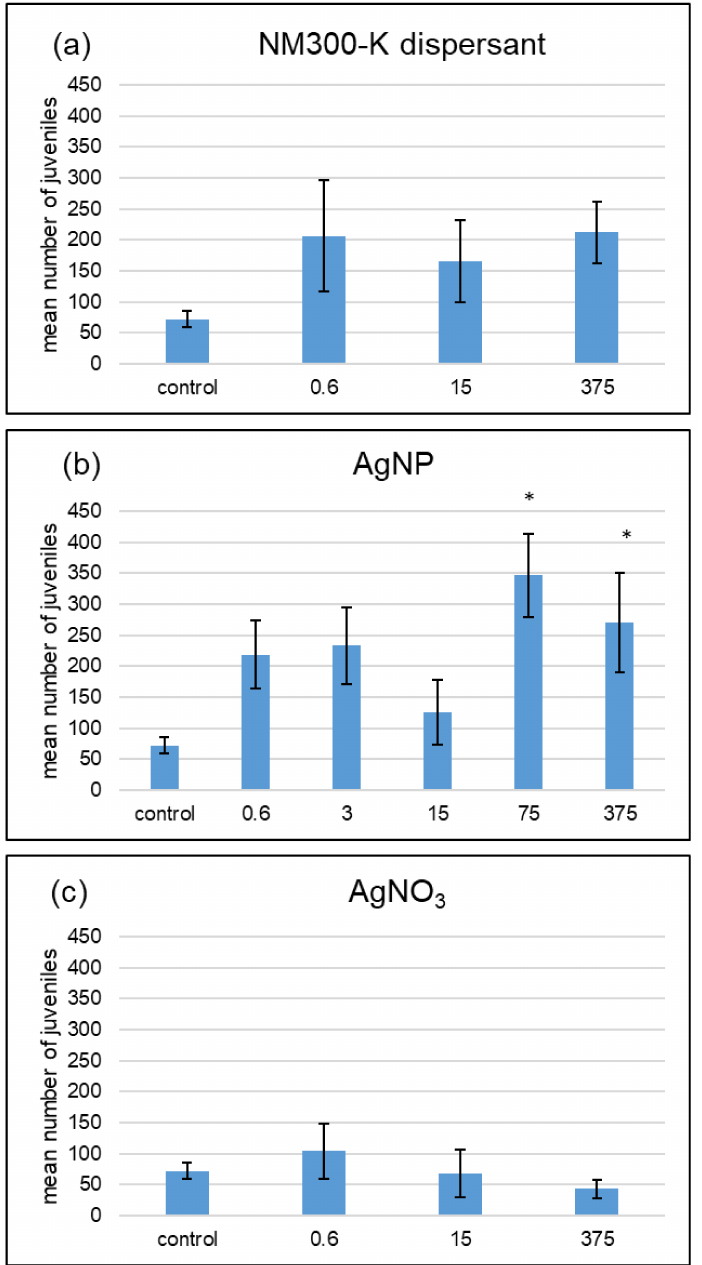
Figure 4. Effects of NM-300K dispersant ( a ), AgNP NM-300K ( b ), and AgNO 3 ( c ) at 60% maximum water holding capacity on F. candida reproduction. Results of a 28-day reproduction test based on the miniaturized OECD test of Filser et al. (2014) [21]. The unit is µ g Ag · kg − 1 soil and the dispersant treatments have the same amount of dispersant as the AgNP treatment labeled with the same concentration. Asterisks indicate significant statistical differences to the respective control (Wilcoxon test, p > 0.05). Mean number of juveniles ± SE, n = 5; control: n =